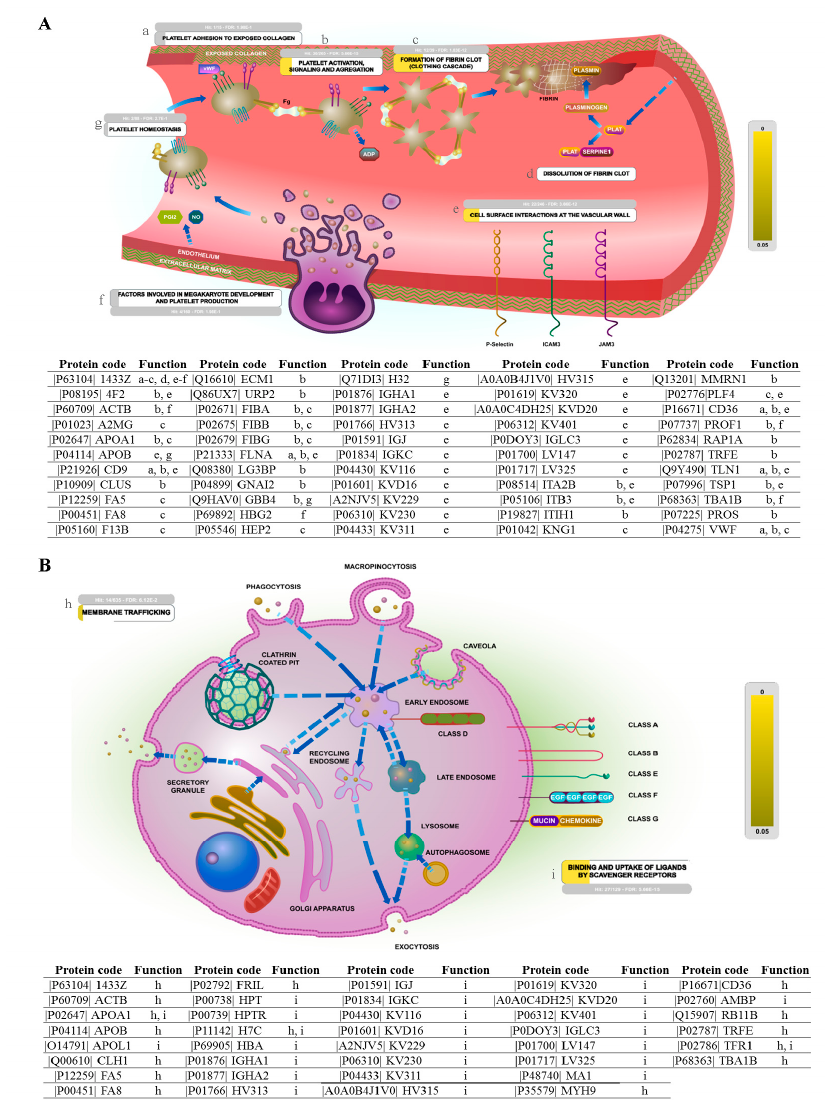
Figure 4. Reactome network view of differentially expressed proteins. ( A ) Hemostasis pathway showing differentially expressed proteins in adults and neonatal exosomes involved in different subpathways (a–g). ( B ) Vesicle-mediated transport pathway showing differentially expressed proteins in adults and neonatal exosomes involved in membrane trafficking (h) or binding and uptake of ligands by scavenger receptors